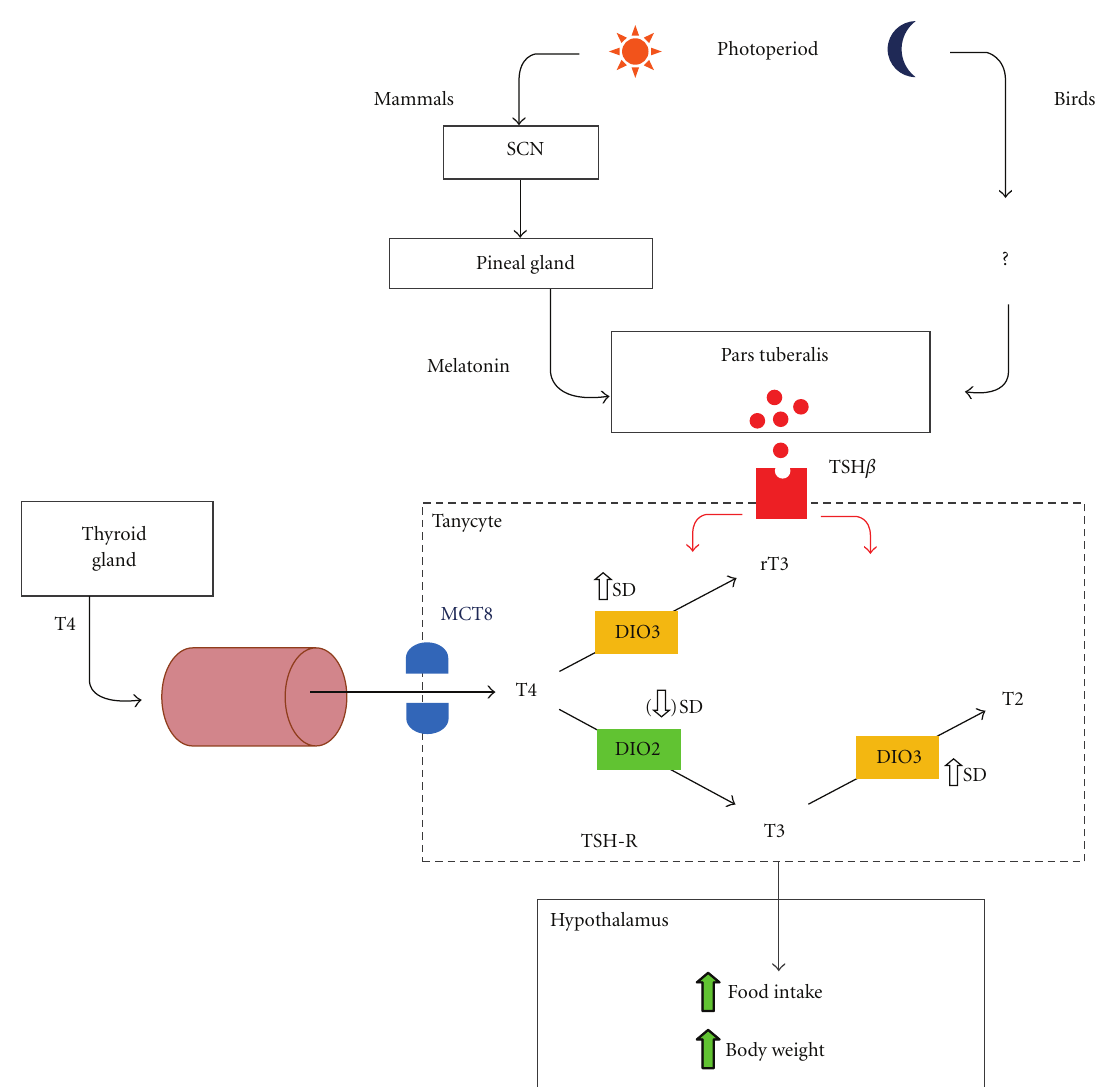
Figure 1: Schematic representation of the influence of photoperiod on deiodinase enzyme gene expression in the hypothalamus. In mammals, photoperiodic information detected by the retina is relayed via the suprachiasmatic nucleus (SCN) to the pineal gland, where the nocturnal secretion of melatonin signals directly to the pars tuberalis . In birds, photoperiodic signalling is not dependent on this pineal- melatonin pathway. Across both vertebrate groups, long photoperiods promote TSH β production by the pars tuberalis which maintains DIO2 expression in tanycytes. T4 is taken up from the circulation via MCT8 transporters and is converted by type 2 deiodinase (DIO2) to T3 which exerts local anabolic actions within the mediobasal hypothalamus. In short photoperiods (SD) the long nocturnal duration of melatonin reduces TSH β production, expression of type 3 deiodinase (DIO3) is upregulated, thus, inactive metabolites of T4 are produced resulting in a catabolic